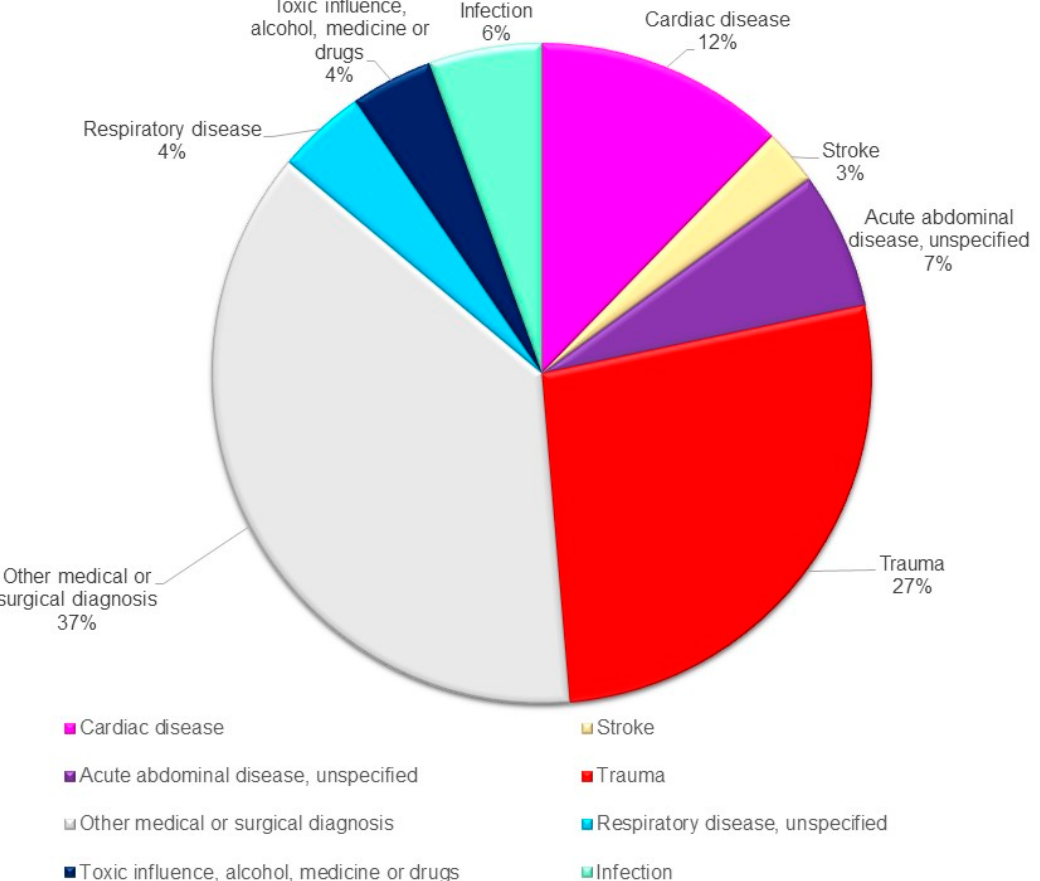
Figure 2. Diagnosis distribution of patients (n: 775) admitted to hospital from the Danish Islands. A total of 95 patients were diagnosed with acute cardiac disease. Fifty-seven patients (60%, CI: 49.4–70.0%) were transported by the HEMS, whereas 24 (25%, CI: 16.9–35.2%) patients were brought to the hospital by a ground ambulance. The proportion of acute cardiac disease among the HEMS patients was greater than among the patients brought to the hospital by a ground ambulance or other means of transportation ( p = 0.001). Of the 95 patients with a diagnosis of acute cardiac disease, 58 (61%, CI: 50.5–70.9%) were transported to one of the five hospitals in Denmark with emergency PCI treatment (percu- taneous coronary intervention) available, and 66% (CI: 51.9–77.5%) of these patients were transported by the HEMS (Table